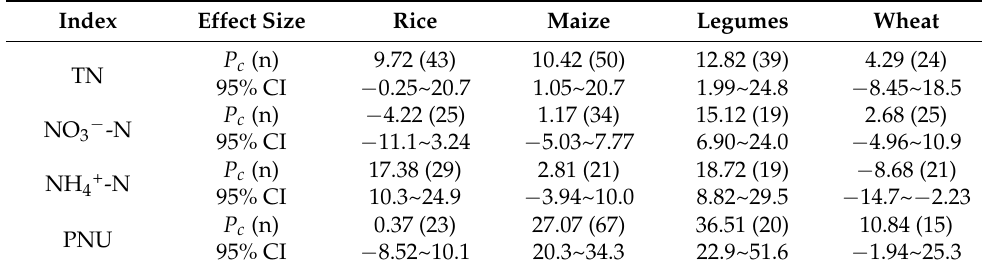
Table 2. Mean values and 95% confidence interval (CI) of percentage changes ( P c : %) in soil N cycle parameters under biochar addition in various crops.